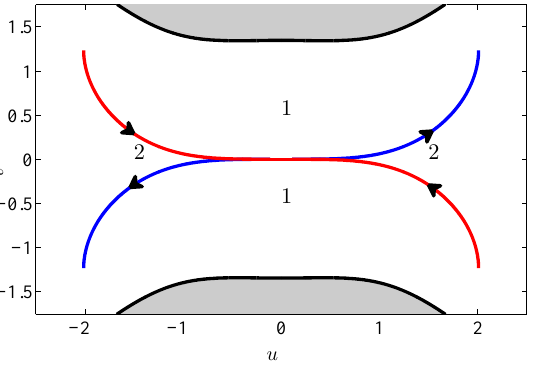
0.2). The thick black line represents the −